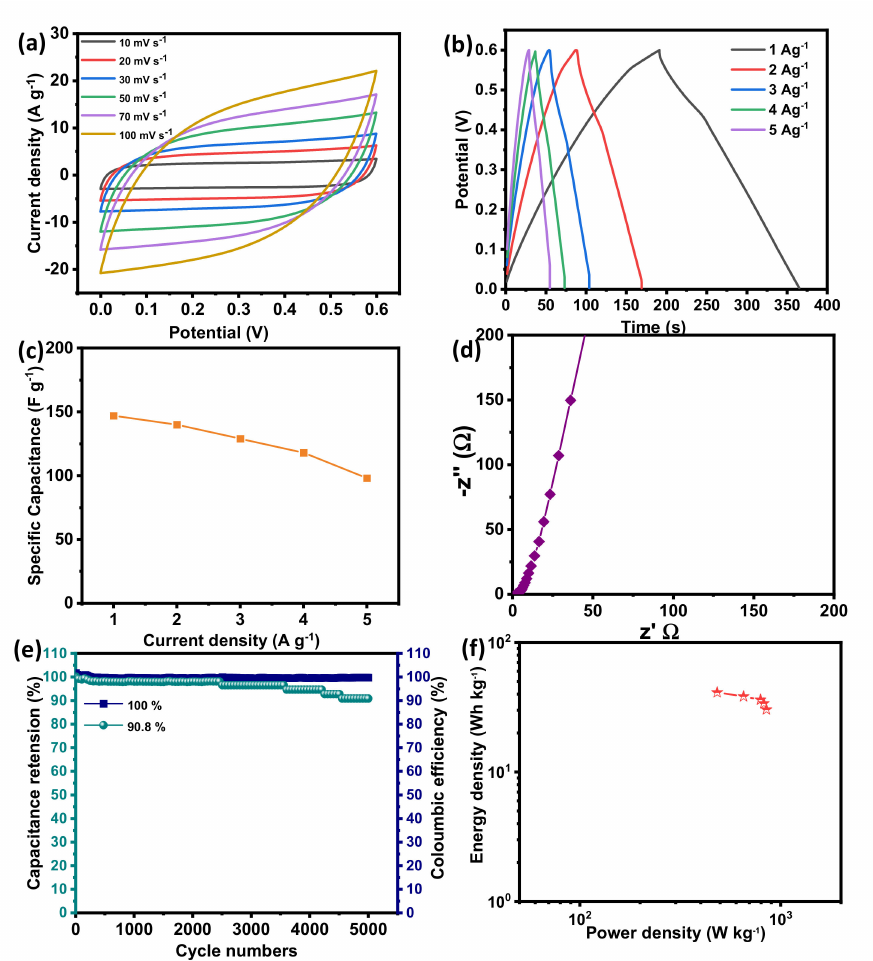
Figure 5. Electrochemical characterization of BSPC electrode in a two-electrode system. ( a ) CV curves at the scan rates of 10 to 100 mV s − 1 . ( b ) GCD curves at the specific current densities of 1 to 5 A g − 1 . ( c ) The specific capacitances at different specific currents ranging from 1 to 5 A g − 1 . ( d ) Nyquist plots with an amplitude of 10 mV s − 1 over a frequency range of 10 − 2 to 10 5 Hz. ( e ) Cyclic stability